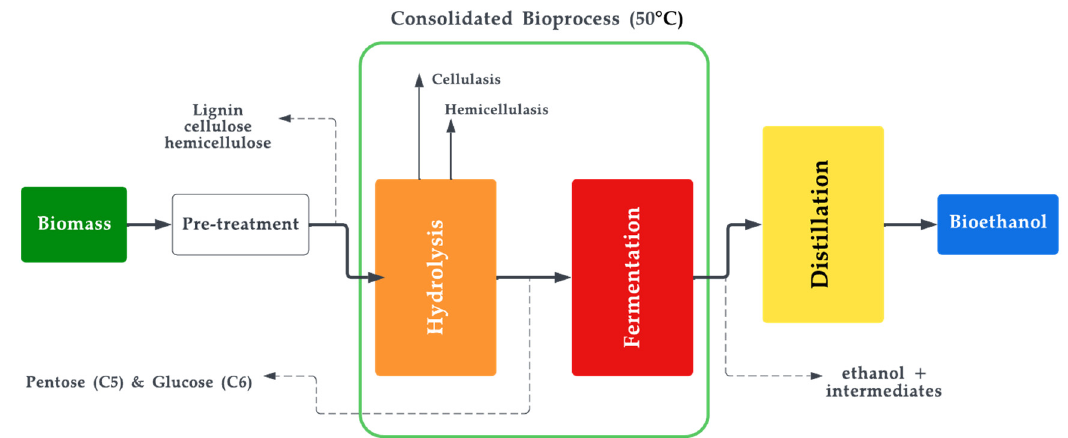
Figure 4. Bioethanol production process.